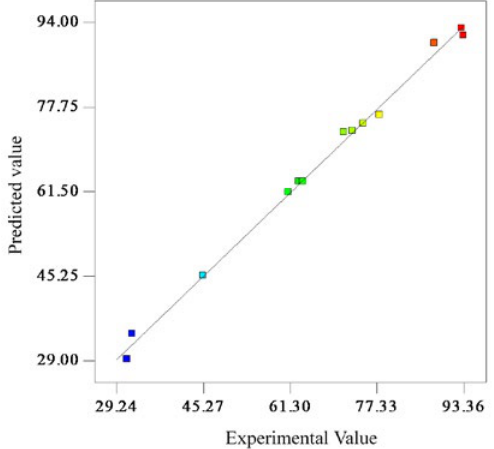
Fig. 7: Predicted vs. experimental values for removal of MB. Table 5: Summary of the main statistical specifications of the response surface quadratic correlation. Std. dev.